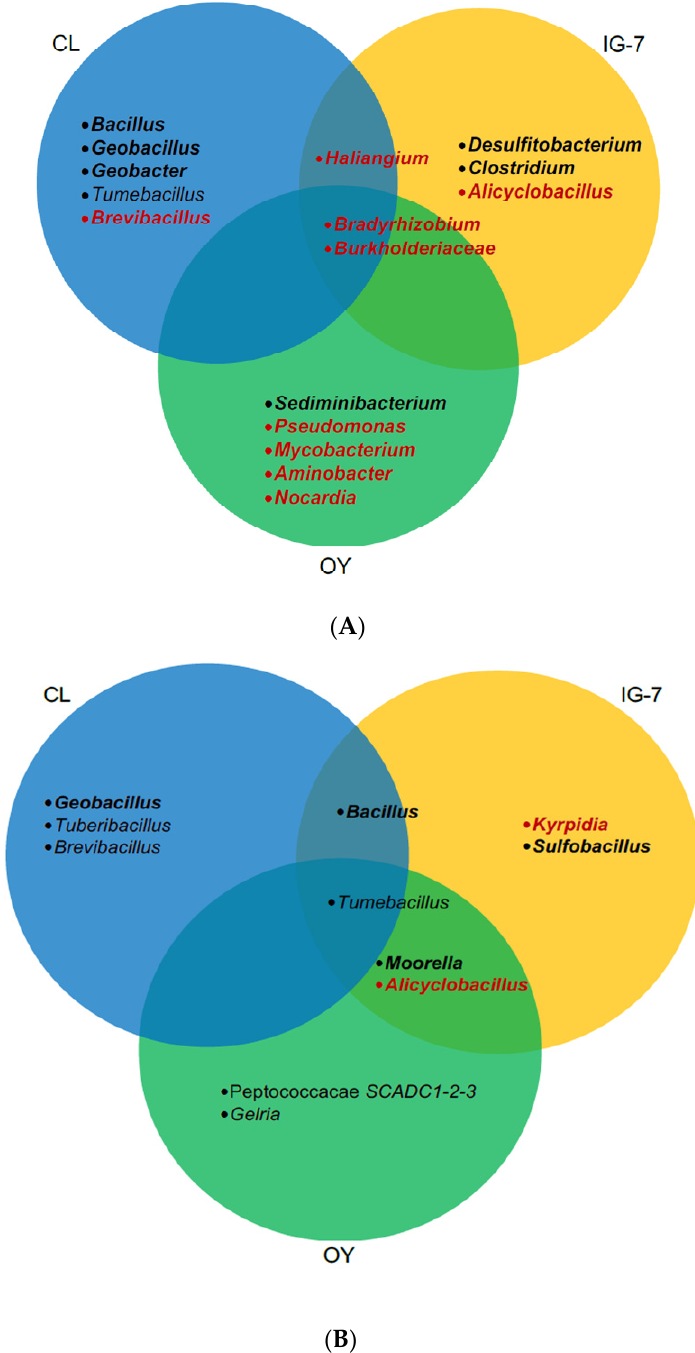
Figure 7. Venn diagram of the distribution of nickel- and molybdenum-dependent CO oxidizers within and among sites at 25 °C ( A ) and 60 °C ( B ); bold black italics represent known nickel-dependent CO-oxidizing genera; bold red italics represent known molybdenum-dependent CO-oxidizing genera; black italics represent putative nickel-dependent CO-oxidizing genera.